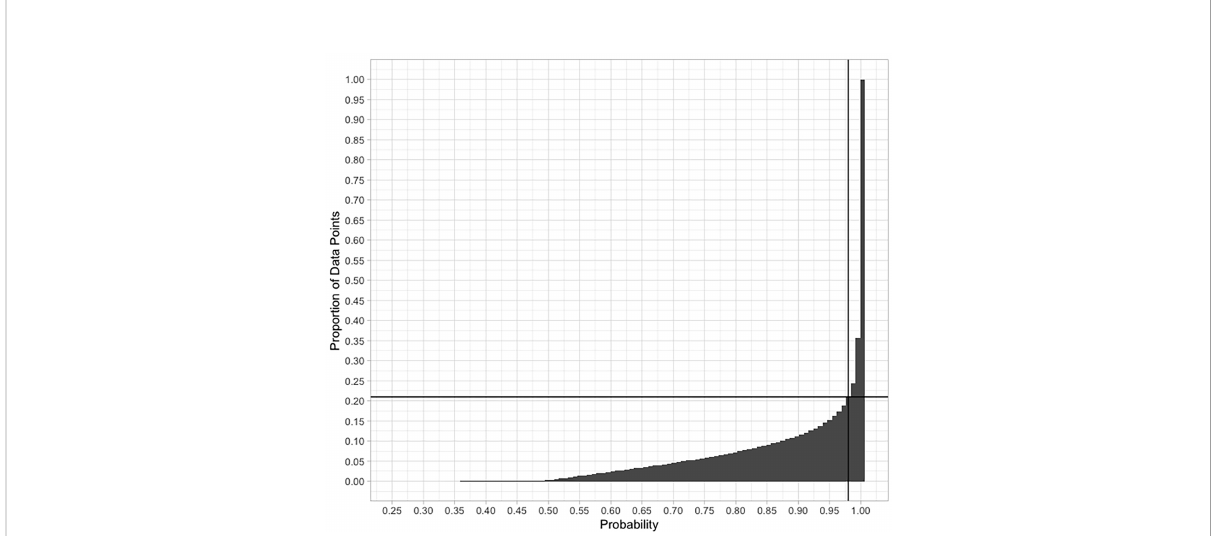
FIGURE 3 A plot of cumulative frequency of observed probabilities in the classi fi cation of individual grid cells into one of the nine SBAs. The lines indicate the 98% probability threshold that includes 79% of the data. Over 85% of the cells are classi fi ed with > 95%